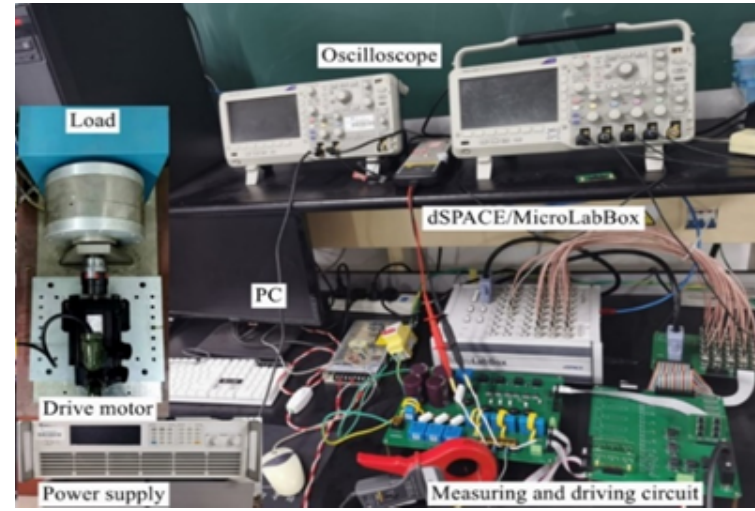
Figure 7. Experimental platform.